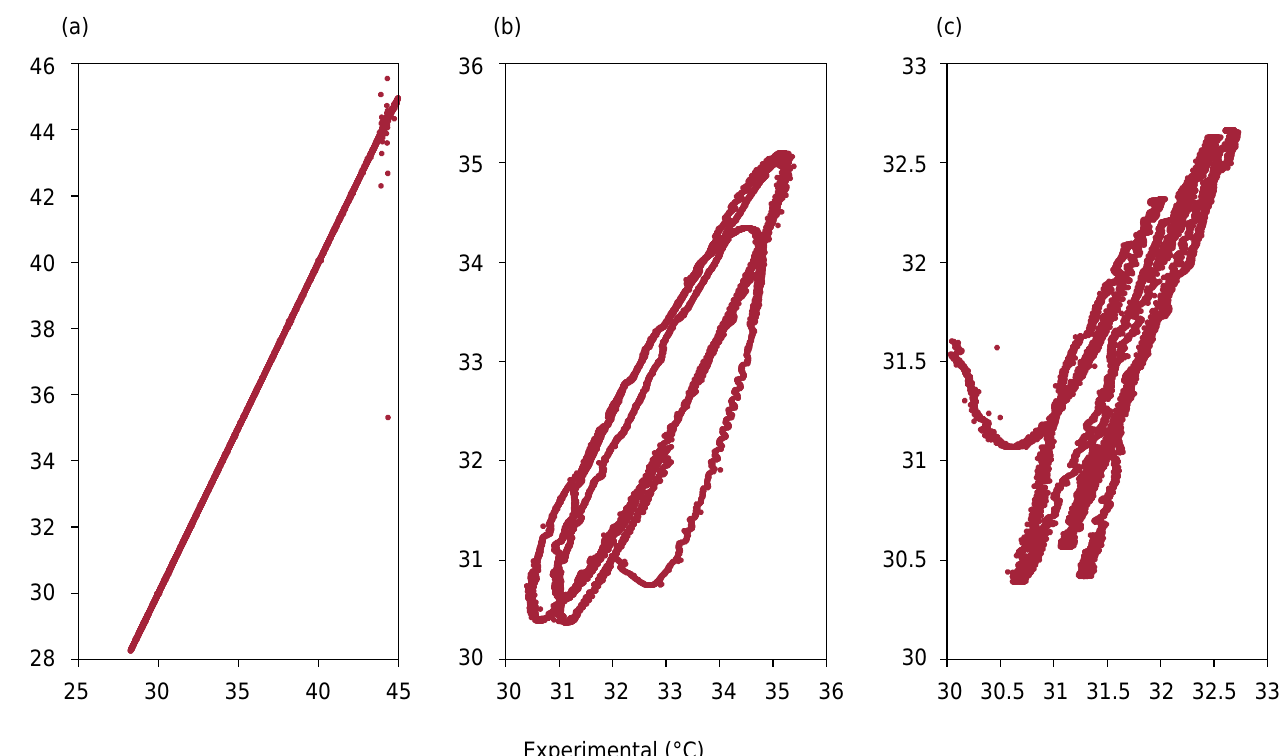
Figure 8. Linear regression model, theoretical temperature = a + b (experimental